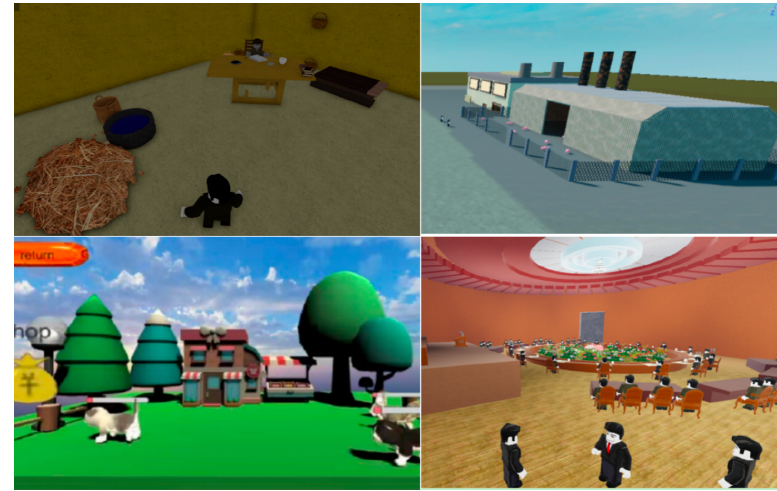
Figure 9. Role-playing